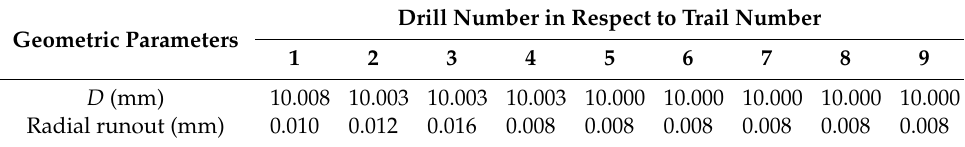
Table 2. Drill bit